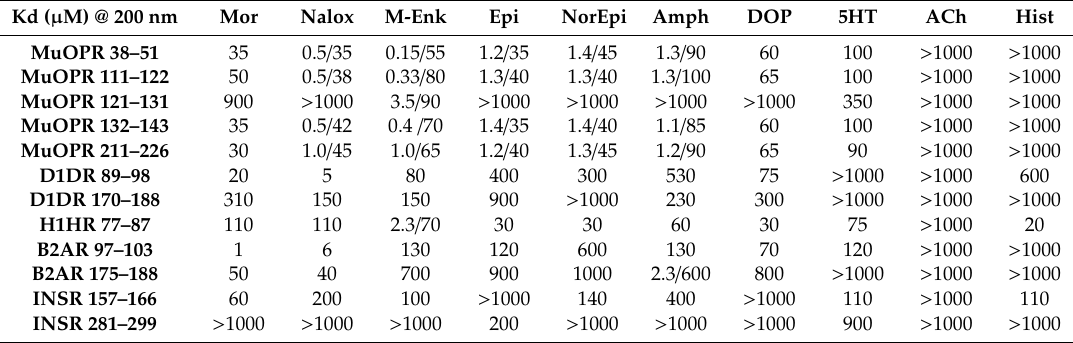
Figure 6. Binding of various bioactive compounds with the mu opioid receptor (muOPR) peptide 38–51. Note that there is high a ffi nity binding at about 1.3 µ M for phenylephrine and isoproterenol, similar to that observed with amphetamine (Figure 4). Morphine, like dopamine (Figure 5), displays only low a ffi nity binding at about 60 µ M, which is also shared by phenylephrine and isoproterenol. Histamine displayed no binding to Mu 38–51. Table 2. Binding constants (in micromoles) measured for various bioactive compounds interacting with the mu opioid receptor (muOPR) peptide, the dopamine D1 receptor (D1DR), the histamine type 1 receptor (H1HR), the beta 2 adrenergic receptor (B2AR), and control sequences from the insulin receptor (INSR). Where two values are presented separated by a slash, evidence of both high a ffi nity and low a ffi nity binding was observed, as illustrated in Figures 4 and